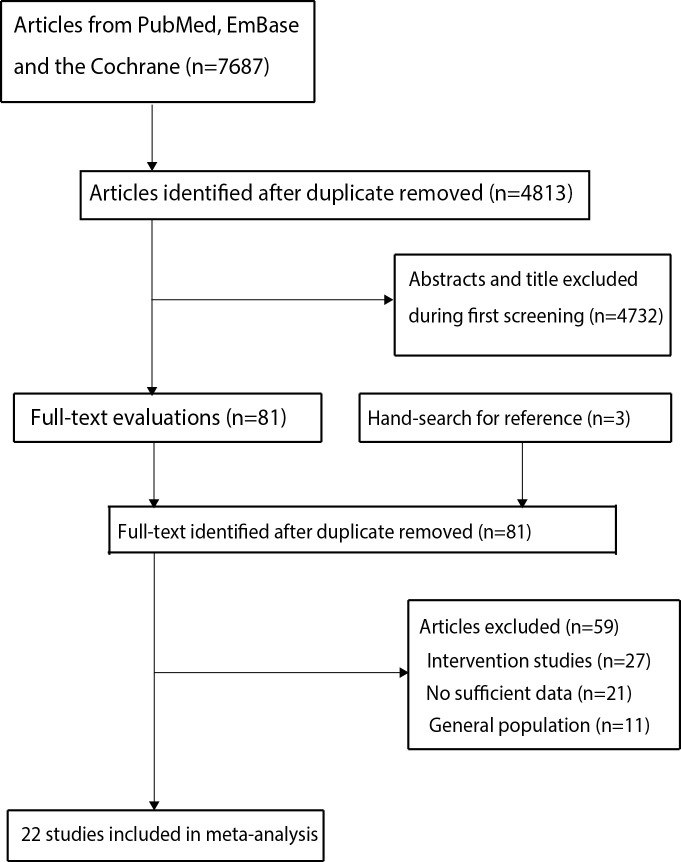
The PRISMA flowchart for the study selection process.